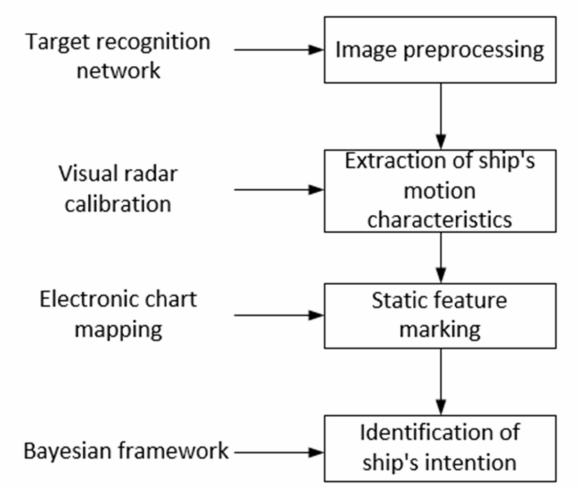
Figure 1. Framework based on vision and Bayesian framework for intent prediction of